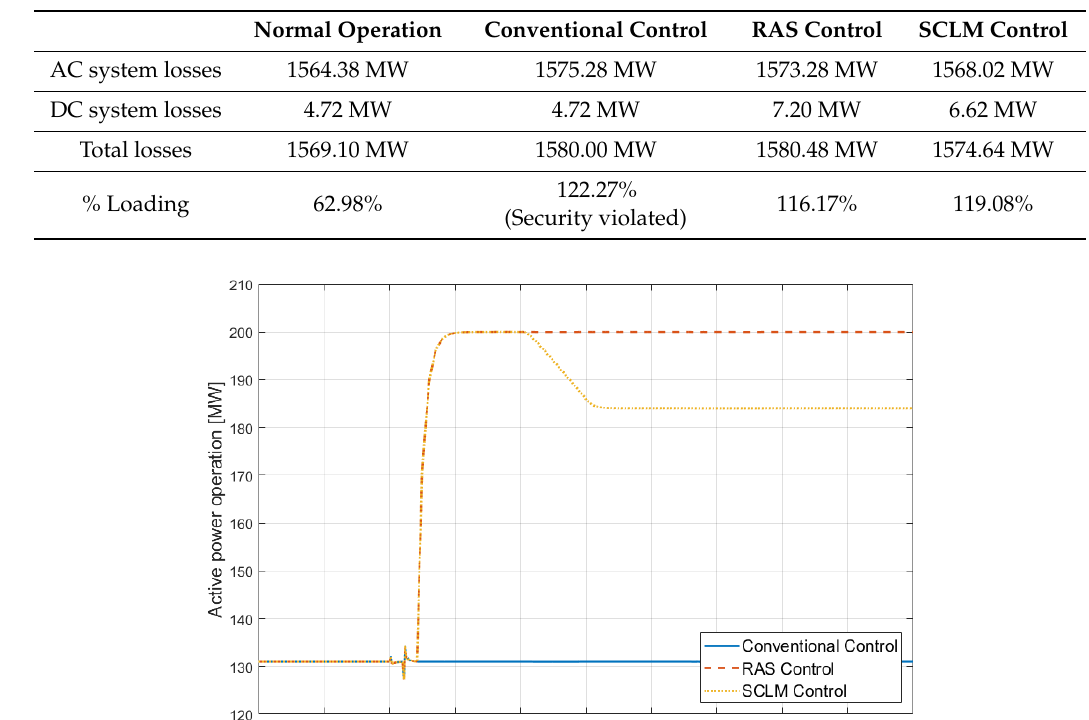
Table 10. Comparison of system losses by operating change (line overload case).